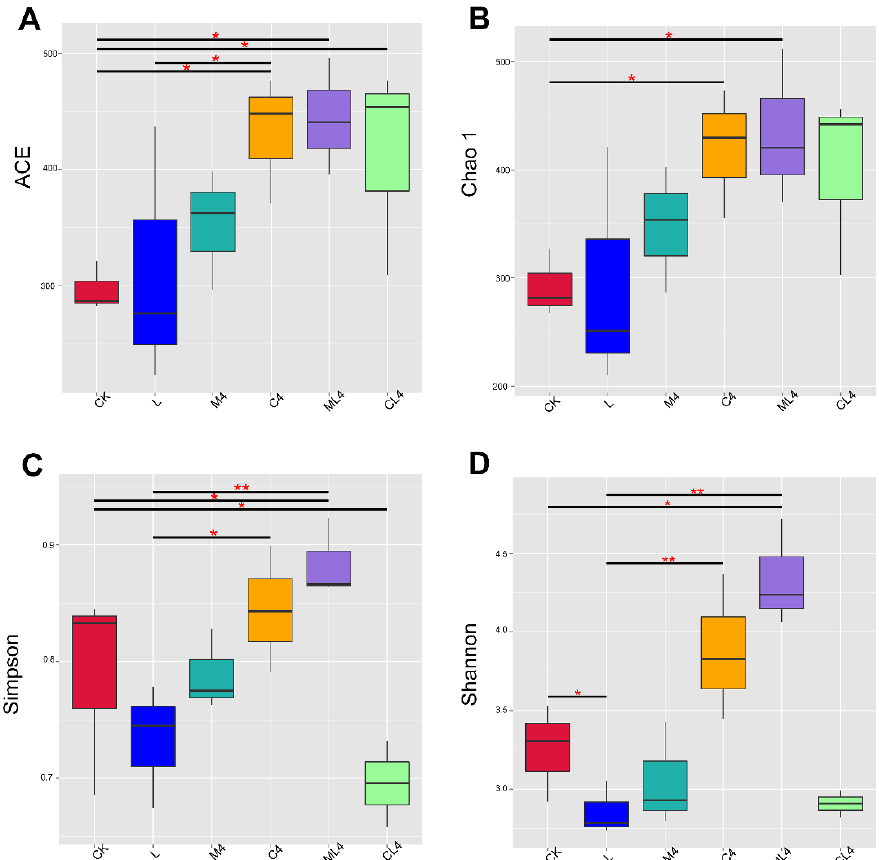
Figure 2. Boxplots showing the distribution of α -diversity indices among silage treatments. ( A ) ACE: Abundance Coverage-based Estimator; ( B ) Chao1 index; ( C ) Simpson’s index; and ( D ) Shannon’s diversity index. The horizontal bars in the boxes represent the median of the distance matrix distribution. The lower and upper extents of the boxes are the 25th and 75th percentiles of the distribution, respectively. The lower and upper whiskers in the box plots are the minimum and maximum values of the distribution, respectively. * p < 0.05; ** p < 0.01.